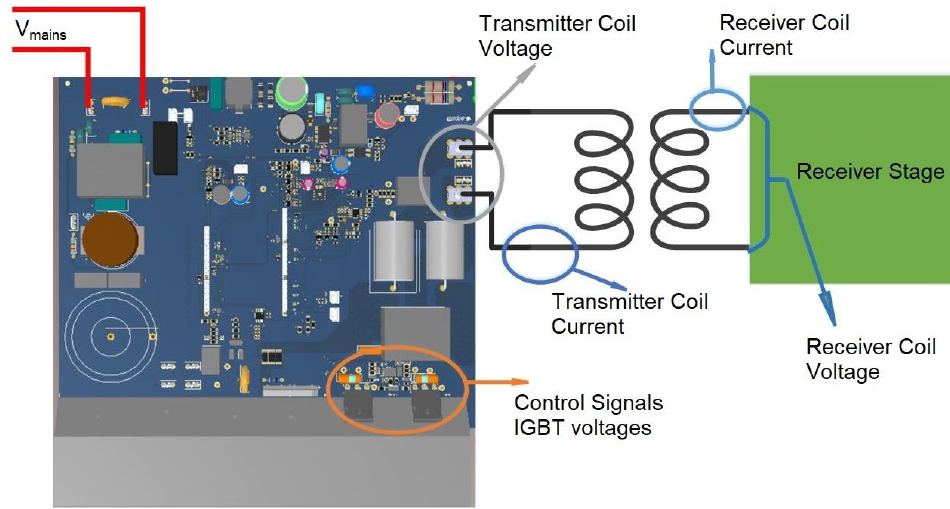
Figure 18. Electronic PCB board and measuring points.